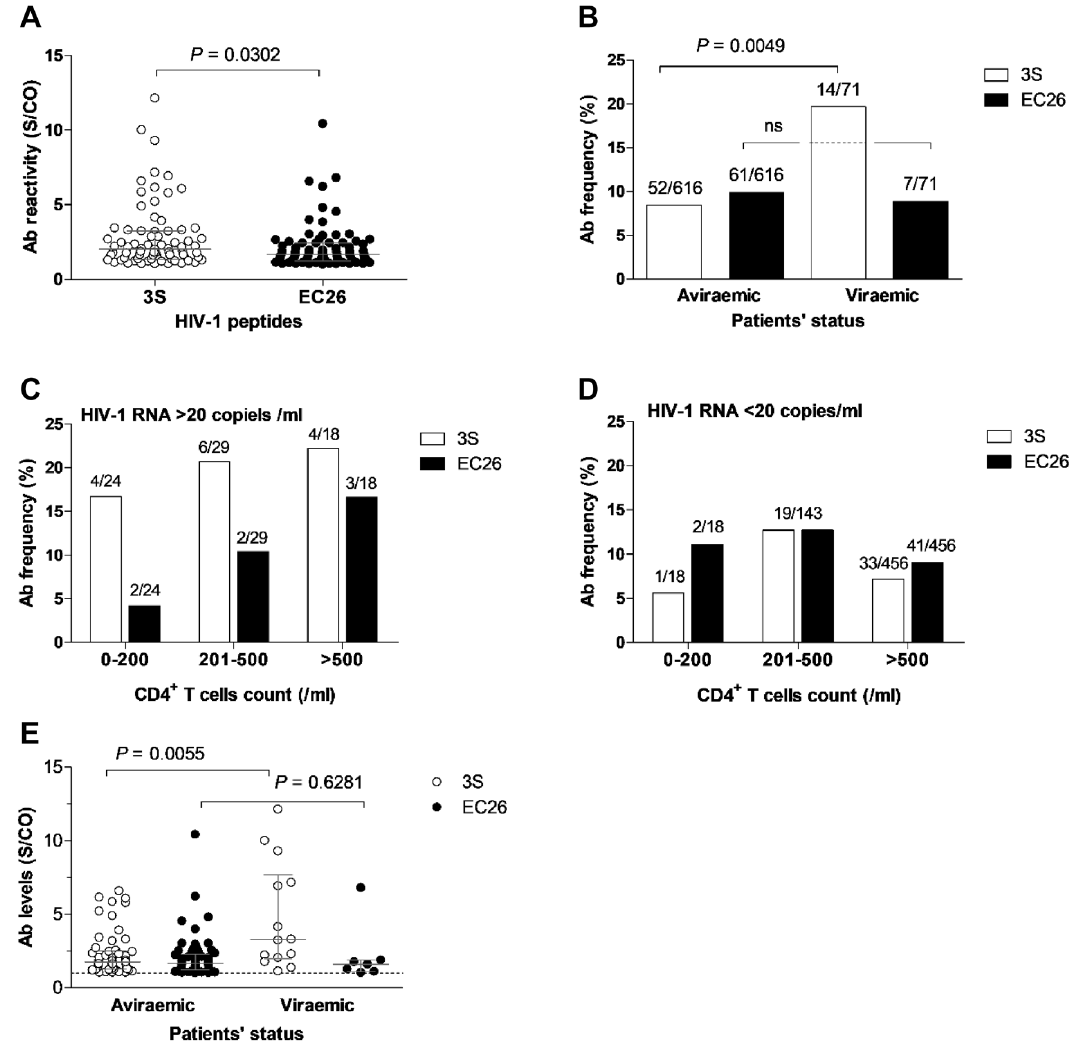
Figure 1. 3S and EC26-specific antibody frequency and reactivity in plasma from HIV-1-infected Portuguese. ( A ) Peptide-specific antibody reactivity levels in all patients; ( B ) Proportion of HIV-1 plasma samples reacting with the peptides in viraemic and aviraemic patients; C and D ) Antibody frequency according to HIV RNA and CD4 + T cells counts; ( E ) Plasma reactivity levels against both peptides in viraemic and aviraemic patients. Lines denote the median and interquartile range. S/CO (OD sample/OD cut-off ratio), values ≥ 1 (dotted line) indicate reactive samples. P values refer to the comparison between groups and were determined using the Mann Whitney test. In all figures, white symbols represent 3S-specific responses and black symbols EC26-specific were also significantly lower in viraemic patients. In contrast, proviral load levels in PBMCs were similar in both groups which may be due to the low number of viraemic patients. Antibody binding reactivity against gp41 peptides. The percentage of samples reacting with 3S or EC26 peptides was similar (N = 66, 9.5% and N = 68, 9.8%, respectively) but the level of reactivity against 3S was significantly higher compared to EC26 [median binding (IQR) = 1.87 (1.34–3.30) vs. 1.64 (1.21–2.20), P = 0.0302] (Fig. 1A). Moreover, reactivity to 3S but not to EC26 was directly related to viral replication. Thus, a similar fre- quency of viraemic and aviraemic patients (9.90% vs 9.86%) reacted with EC26, but much higher frequency of viraemic patients reacted with 3S relative to aviraemic patients (19.72% vs. 8.44%, P value = 0.0049) and this was irrespective of the number of CD4 + T cells (Fig. 1B–D). Likewise, the antibody reactivity level against 3S was sig- nificantly higher in viraemic patients compared to aviraemic patients [median binding (IQR) = 3.27 (1.98–7.68) vs. 1.76 (1.28–2.52), P = 0.0055], while no significant difference was observed for EC26 [median (IQR) bind- ing = 1.59 (1.11–1.88) vs. 1.66 (1.21–2.29), P = 0.6281] (Fig. 1E). Interestingly, in viraemic patients, viral load was lower in patients with antibodies against EC26 relative to patients with no antibody reactivity or with antibodies against 3S. This difference reached statistical significance when comparing patients with no antibodies with patients with EC26 antibodies (2.74 vs. 1.99 median log 10